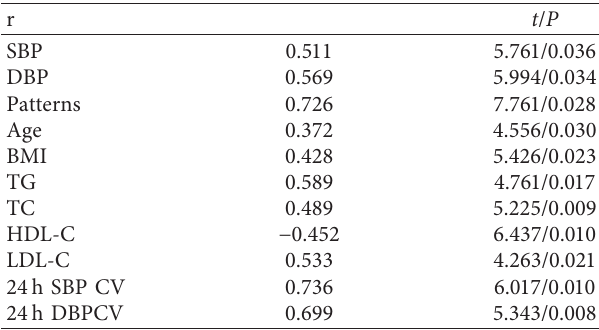
Table 3: Correlation coefficient for the association between LVMI and other